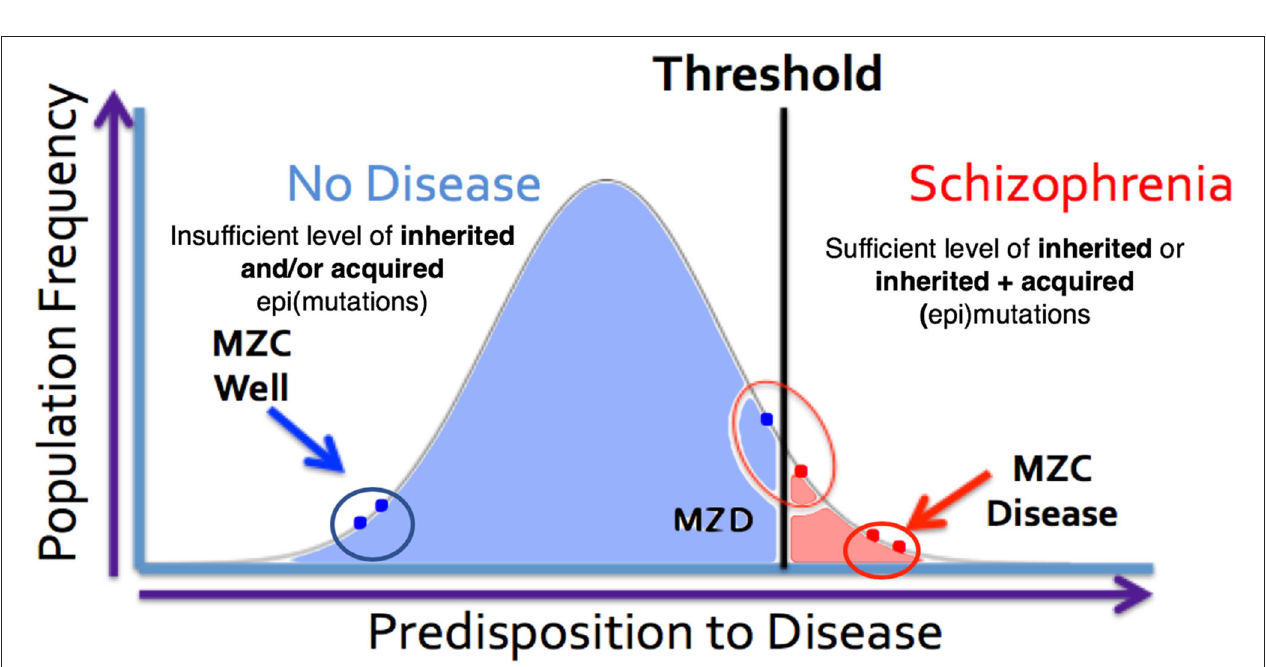
FIGURE 3 | The genetic threshold required for the development of a neurodevelopmental disease may be met by (1) A major gene insult; (2) An adequate level of polygenic mutations; or (3) A combination of inherited (a) plus acquired somatic mutations (b) and/or somatic epimutations (c).